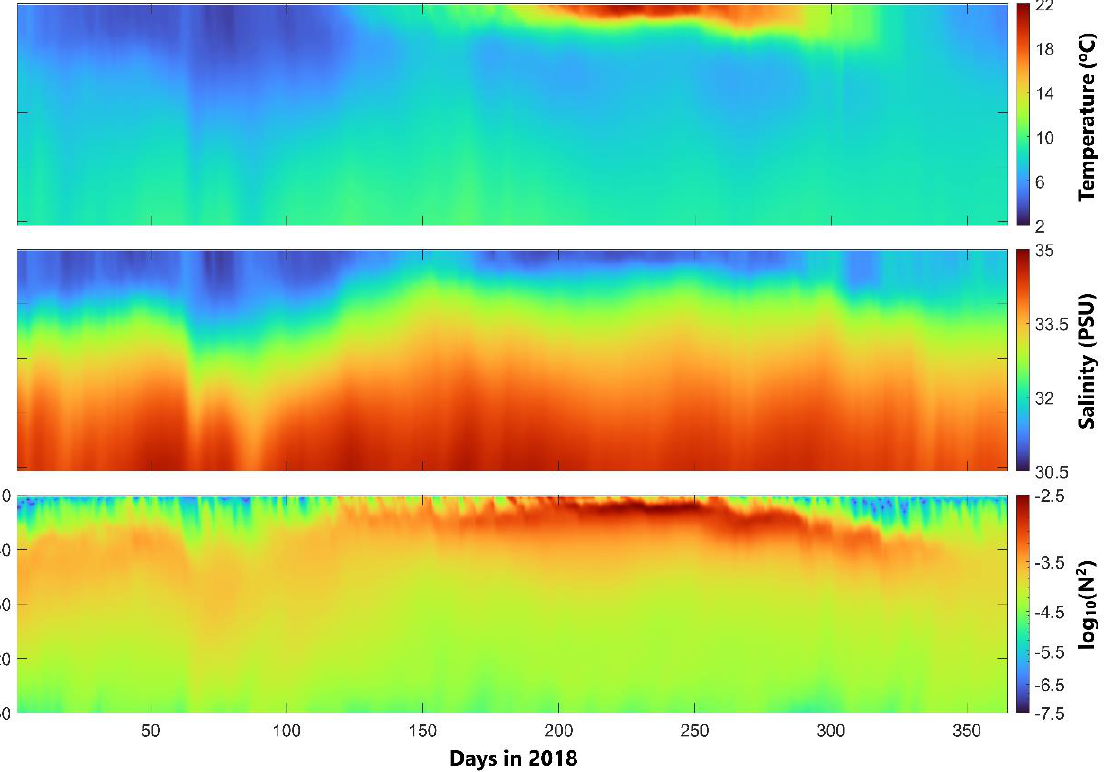
Figure A2. Time series of ( a ) temperature, ( b ) salinity, and ( c ) log (Figure 1b, in the swScS) in 2018. The time series of temperature, salinity, and log based on the daily-mean model results produced by submodel